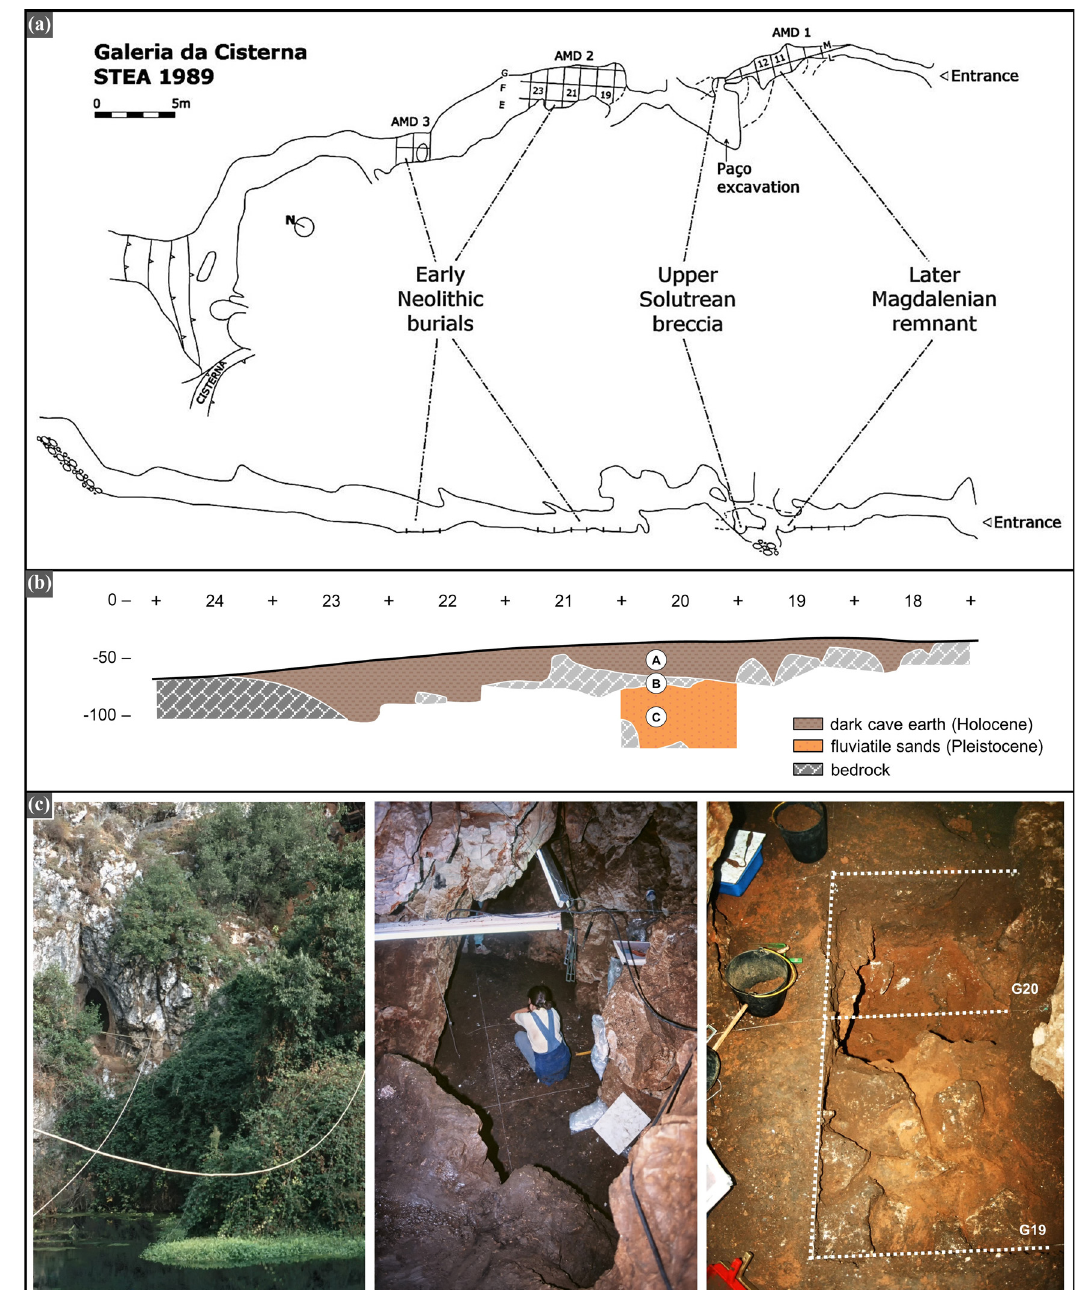
Figure 1: Galeria da Cisterna. Excavation and stratigraphy. ( a ) Plan and cross - section of the passage, archaeological zones, and 1988 – 1989 excavation grid. ( b ) Stratigraphic pro fi le along the F > G axis of zone AMD2 ( elevations in cm below datum ) . ( c ) Entrance to the passage ( left ) , overview of zone AMD2 prior to excavation ( centre ) , and the basal fl uviatile sands of layer C, exposed ( in G19 ) , or excavated ( down to bedrock, in G20 ) ( right )